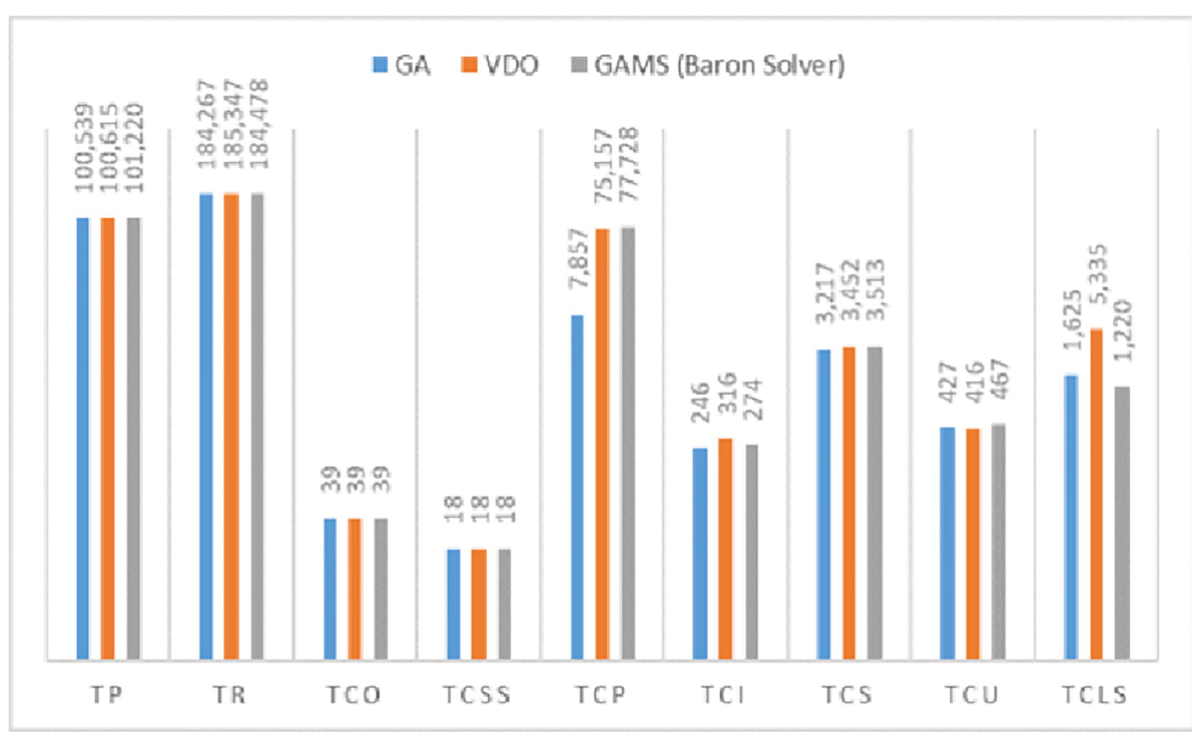
Fig 10. The comparison of the costs and incomes of designing the system with different solving methods.